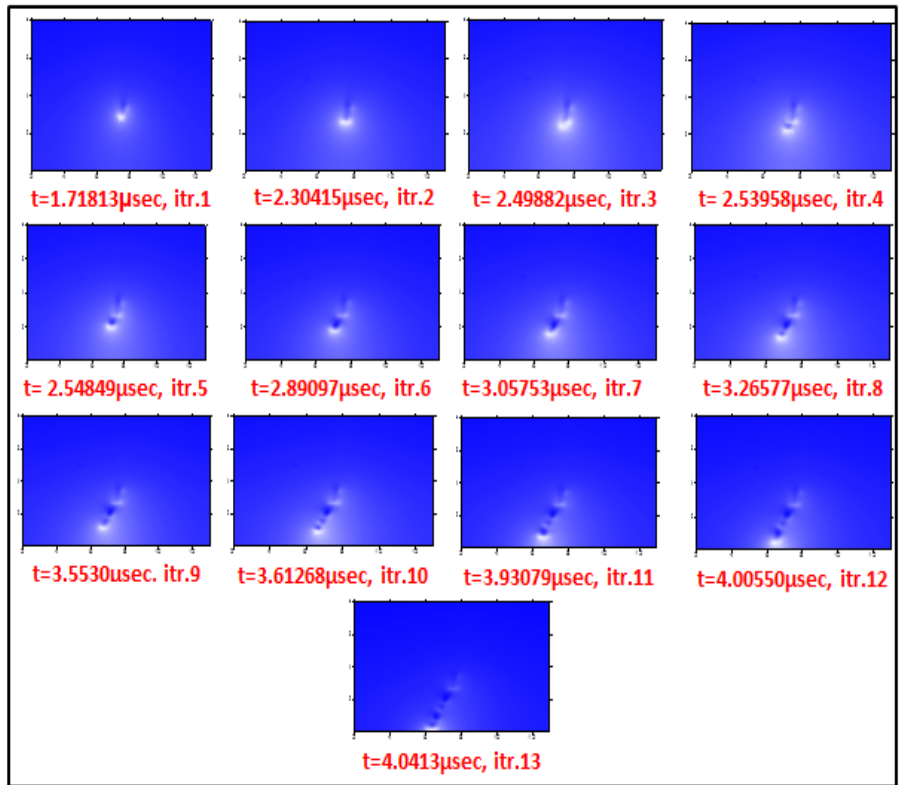
Fig. 5: Magnitude distribution to the electric field distribution with the time within pin - plane configuration in applied voltage of V = 13